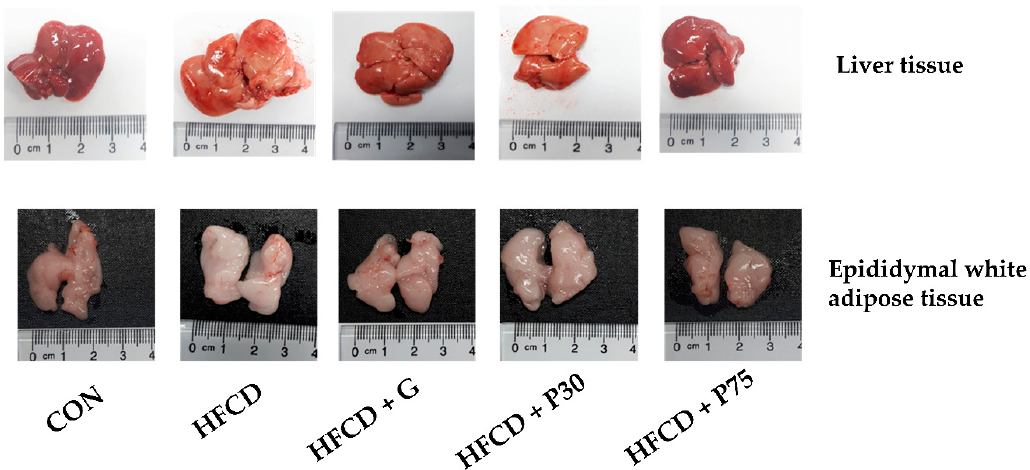
Figure 1. Representative images of liver and epididymal white adipose tissue. Representative macroscopic pictures of male C57BL/6 mice from different groups at the end of the experiment. After sacrifice of the mice, liver and epididymal white adipose tissue were obtained and photographed. Control (CON): AIN-93G diet, high fat / cholesterol diet (HFCD): 60% calories from fat + 1% cholesterol,